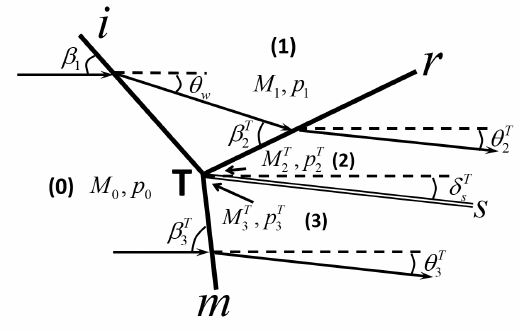
Figure 6. Triple point